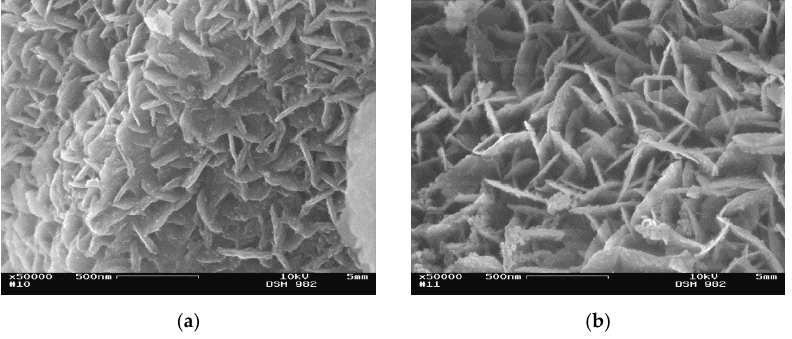
Figure 9. SEM images of ( a ) M2(5)/SiO 2 90:10 and ( b ) M2(12)/SiO 2 90:10 at 50,000× magnification.